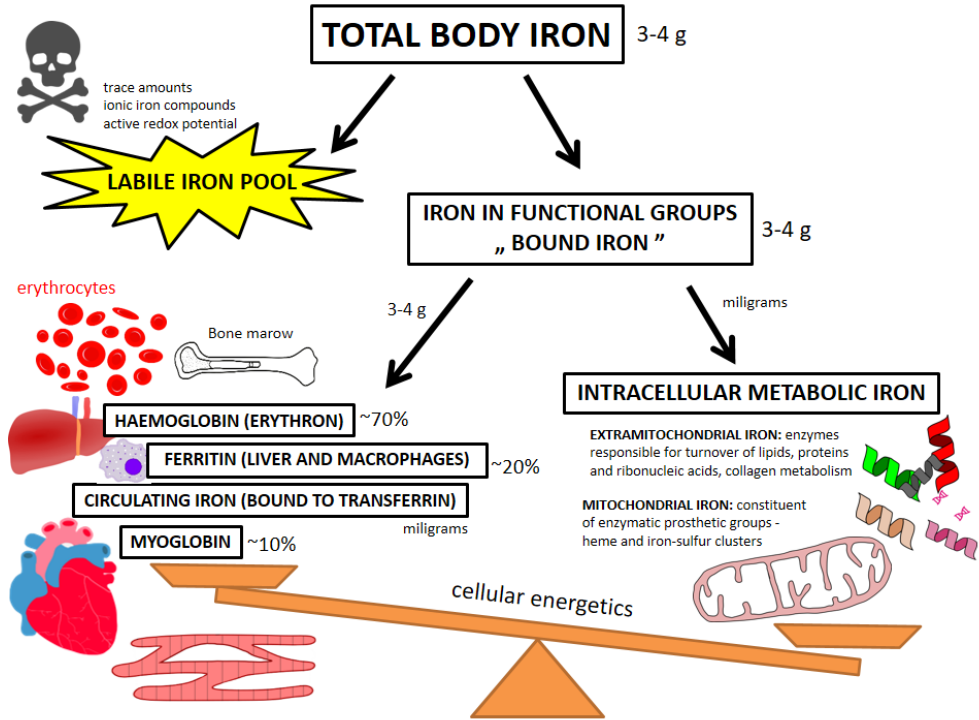
Figure 1. Iron pools in the body with special emphasis on physiological roles.